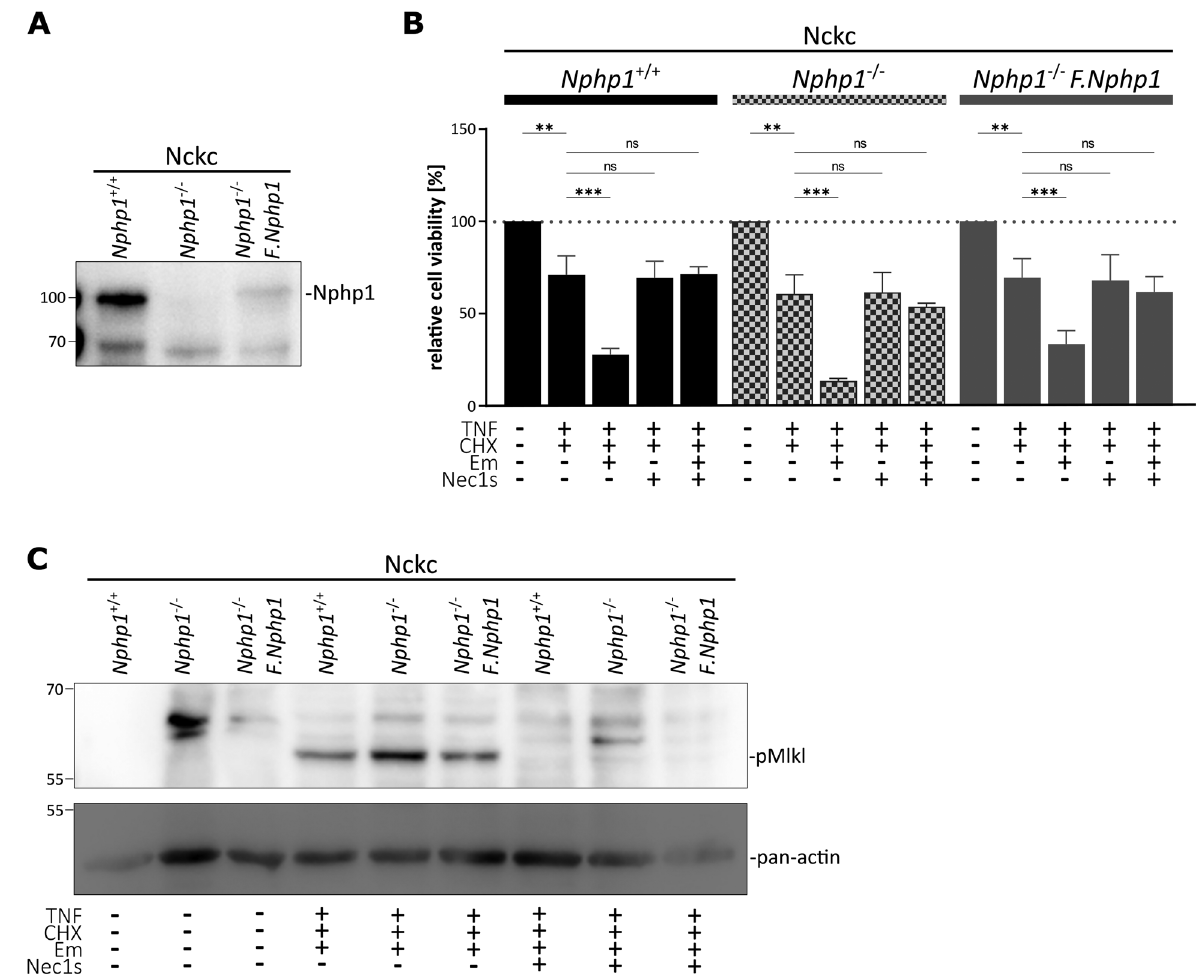
assay in Nckc pro fi cient and de fi cient in Nphp1. RCD induction with TNF α (TNF, 4 ng/100 µl) and cycloheximide (CHX, 2 µg/100 µl) for 16 h. Additionally, caspase-8 inhibitor emricasan (Em, 10 µM) and necroptosis inhibitor necrostatin-1s (Nec1s, 40 µM) were used for 16 h ( n =